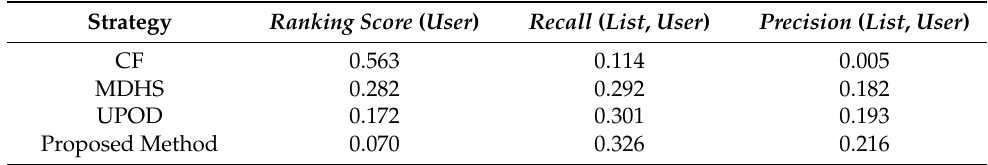
Table 9. Performance comparison based on µ .